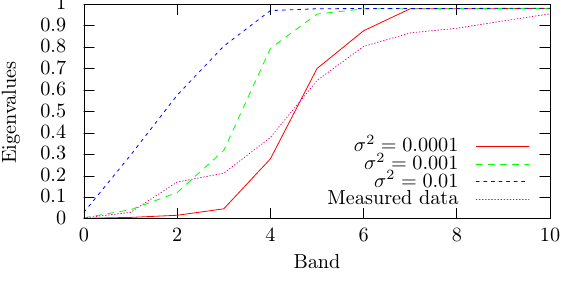
Figure 2. Eigenvalues obtained from the MNF transforms (simulated and experimental